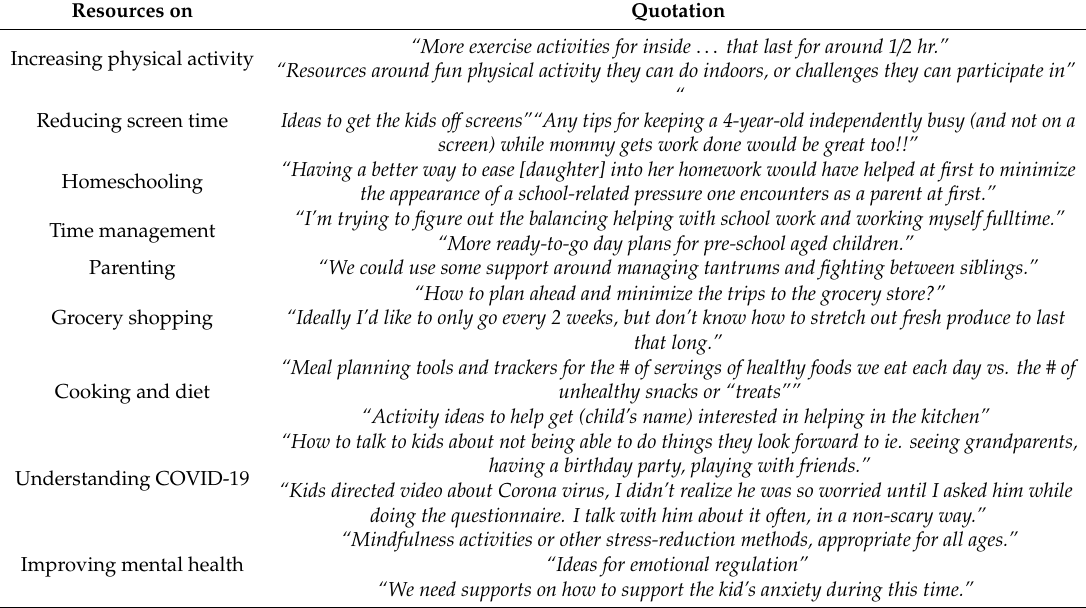
Table 3. Selected quotes illustrating resources parents perceived as